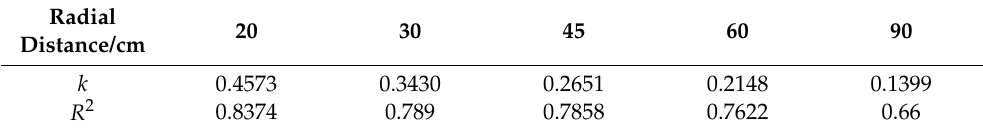
Table 2. Adjustment factors for deflection temperature at different radial distances. Radial